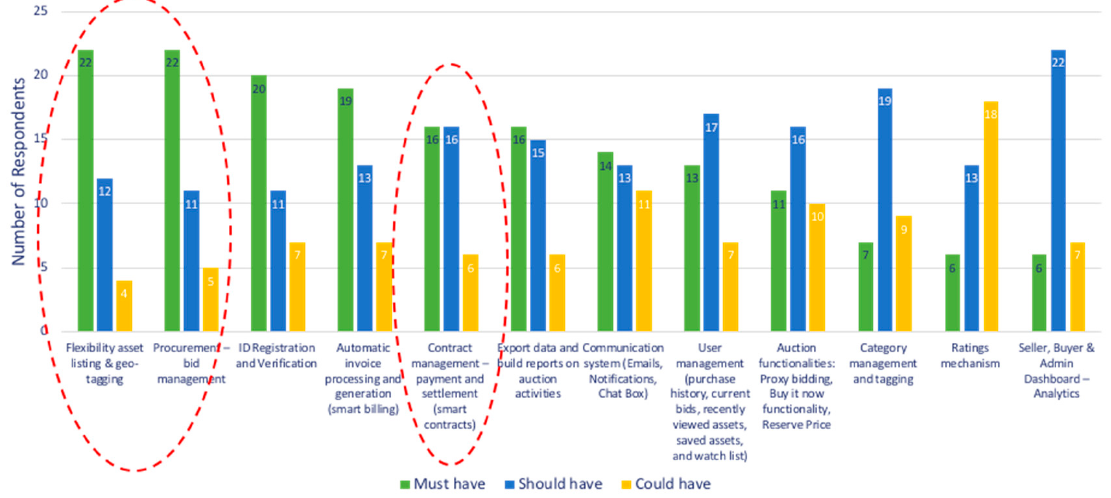
Figure 7. Survey participants preference to features and